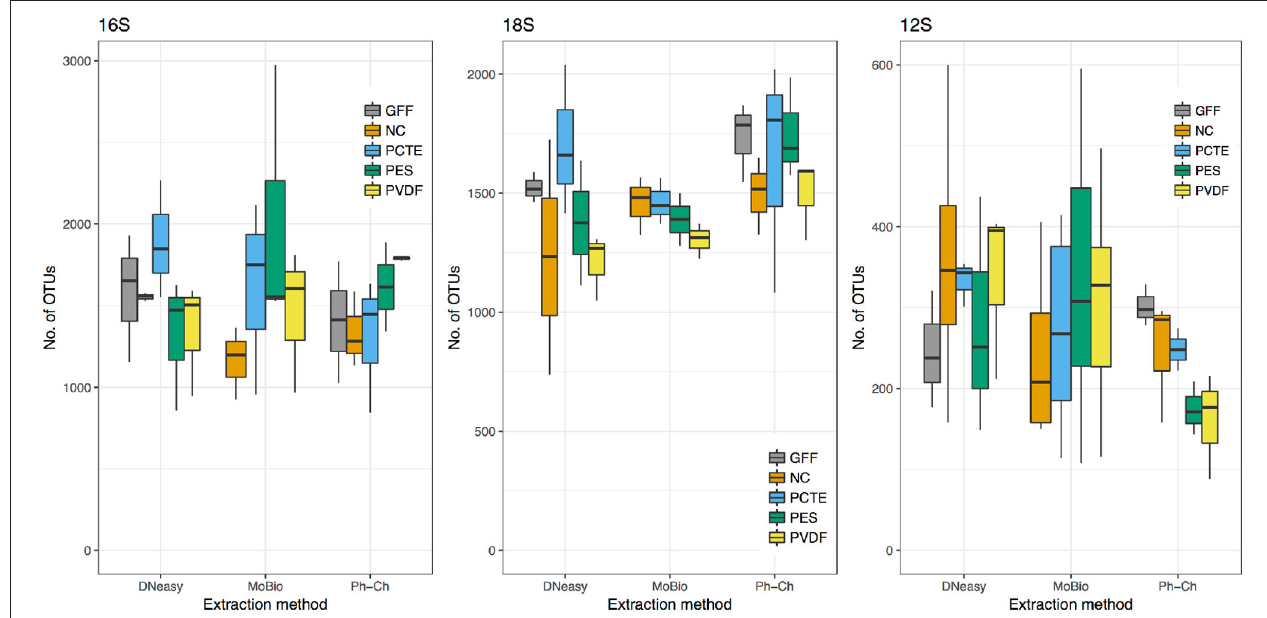
FIGURE 3 | Distributions of the number of OTUs obtained for the 14 treatments (excluding GFF-MoBio which did not yield DNA) for the 16S rRNA gene (microbes), the 18S rRNA gene (phytoplankton), and the 12S rRNA gene (vertebrates). n = 3 for each box, note the difference in scales for each marker gene.